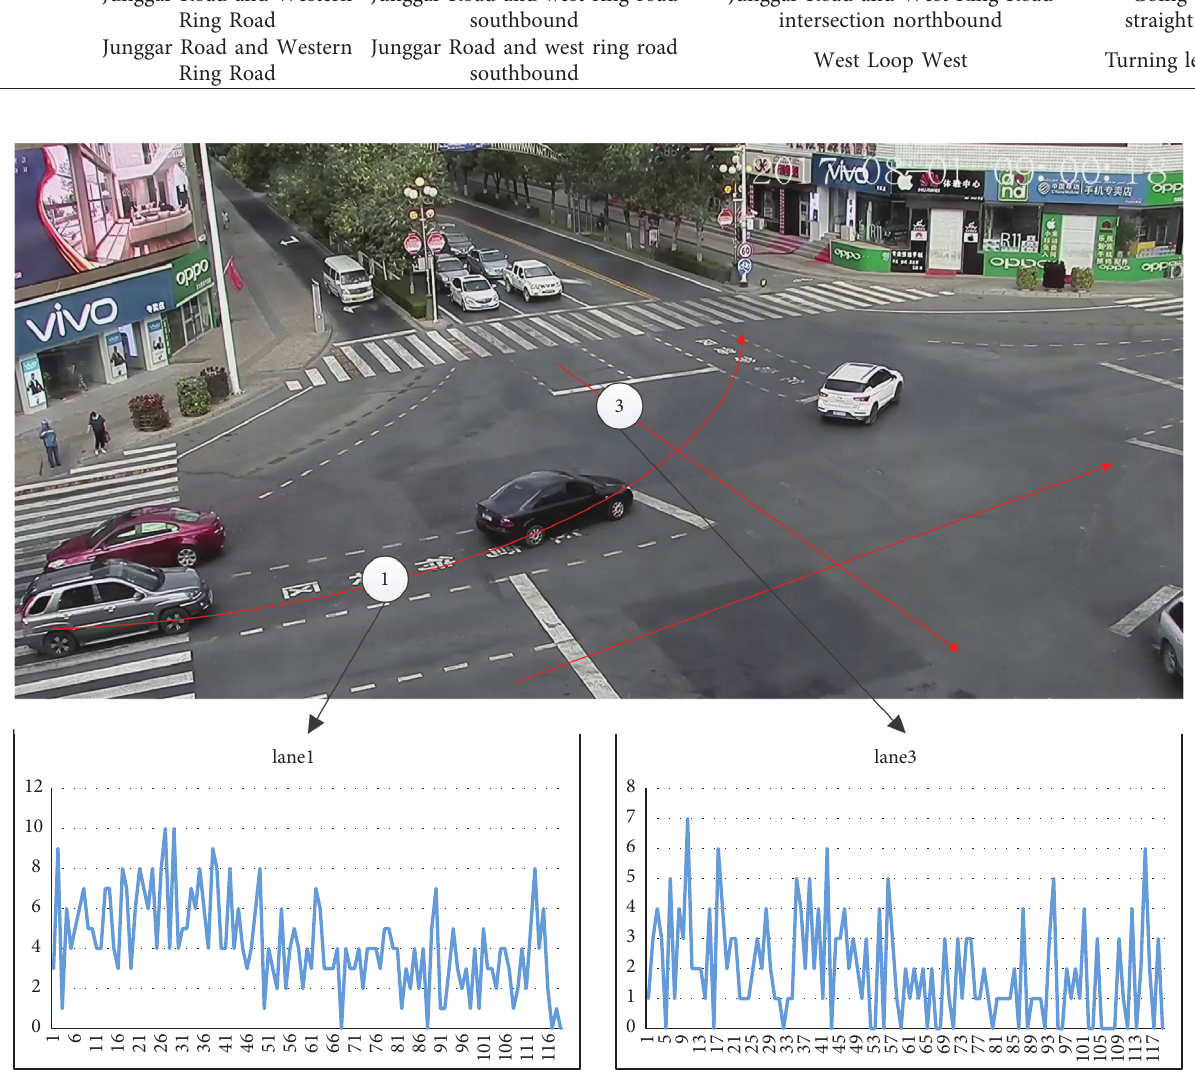
Figure 11: Flow data for each